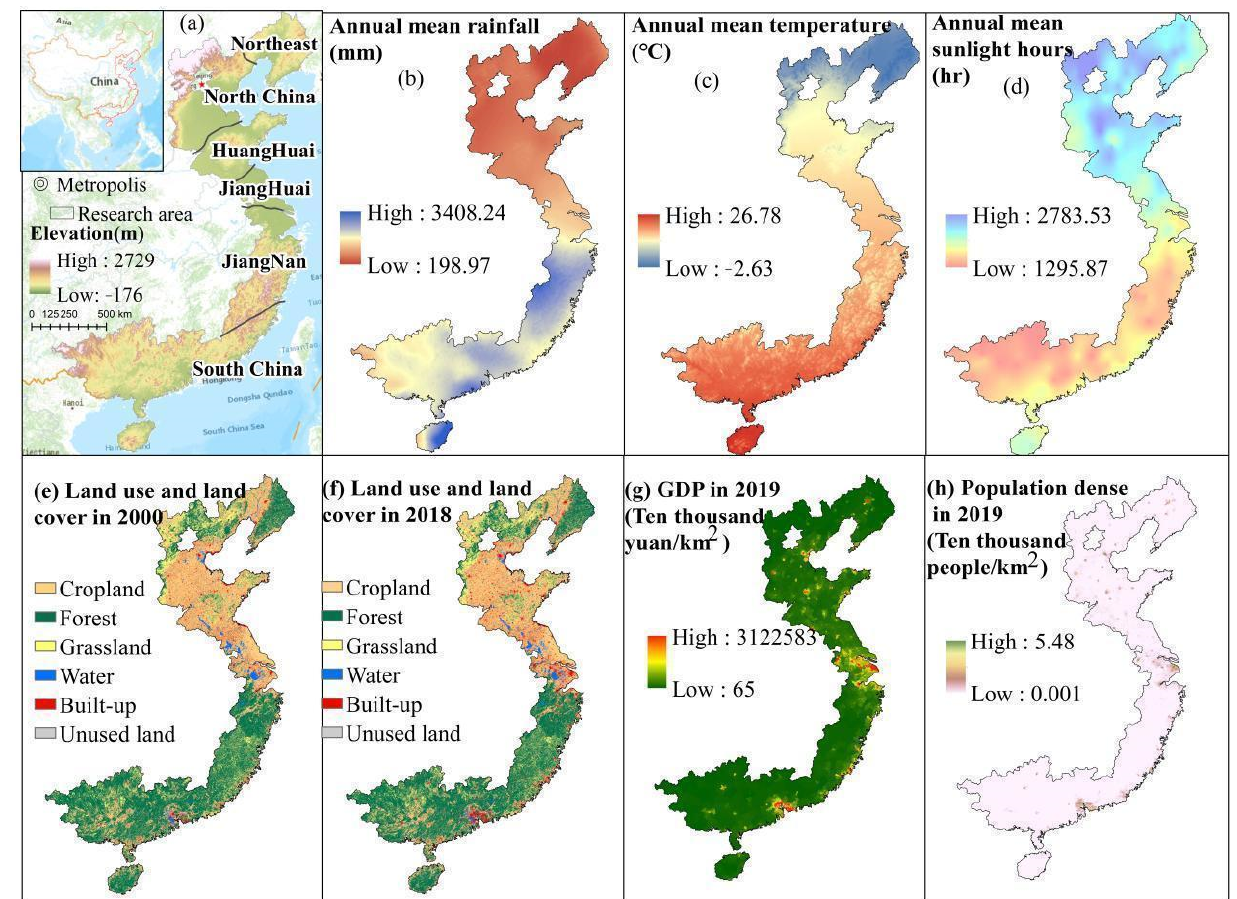
Figure 1. Background information for coastal China.